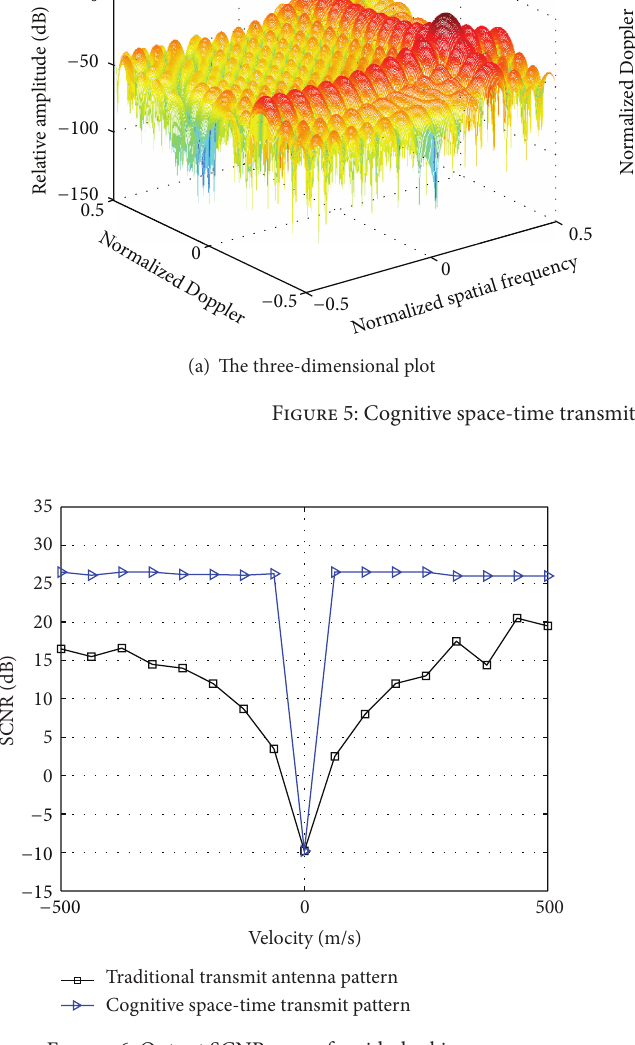
Figure 6: Output SCNR curve for side-looking case. Figure 7: Output SCNR curve for forward-looking